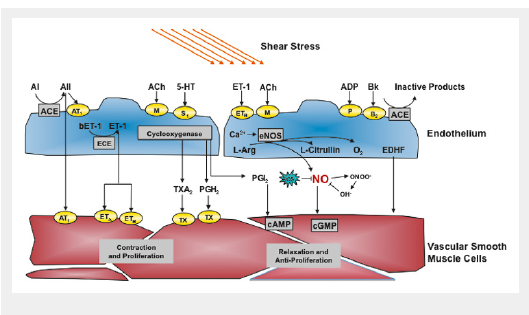
Endothelium-derived vasoactive substances. Endothelial nitric oxide synthase is induced by shear stress and a variety of receptors and leads to a release of nitric oxide (NO), which exerts relaxation of vascular smooth muscle cells and other important effects such as antiproliferation and inhibition of thrombocyte aggregation and leukocyte adhesion. Other endothelium-derived relaxing factors including endothelium-derived hyperpolarisating factor (EDHF) and prostacyclin (PGI2) are also shown. ACE denotes angiotensin-converting enzyme, Ach, acetylcholine; AI, angiotensin I, AII, angiotensin II, AT1, angiotensin 1 receptor; Bk, bradykinin; COX, cyclooxygenase; ECE, ET- converting enzyme; EDHF, endothelium-derived hyperpolarizing factor; ET A and ET B , endothelin A and B receptors; ET-1, endothelin-1, L-Arg, L-arginine; PGH 2 , prostaglandin H 2 ; ROS, reactive oxygen species; S 1 , serotoninergic receptor; TH, throm- boxane receptor; Thr, Thrombin; TXA 2 , thromboxane; 5-HT,